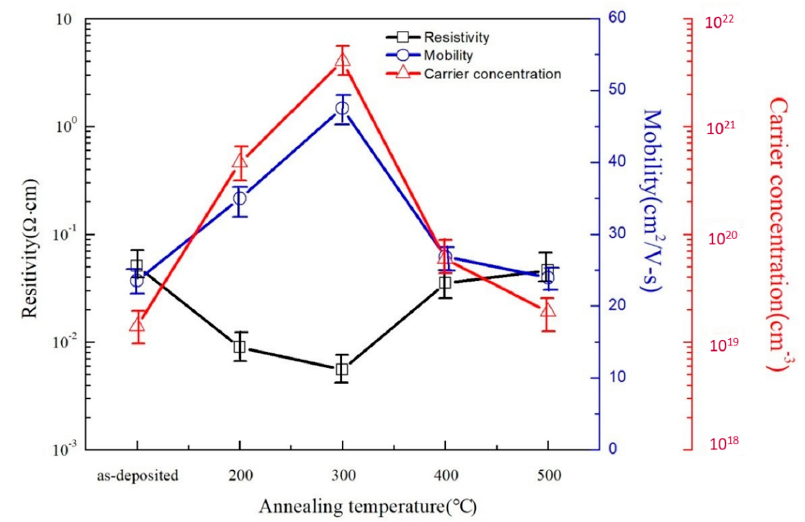
Figure 2. Electrical properties of as-deposited and annealed Ti:SnO 2 films.